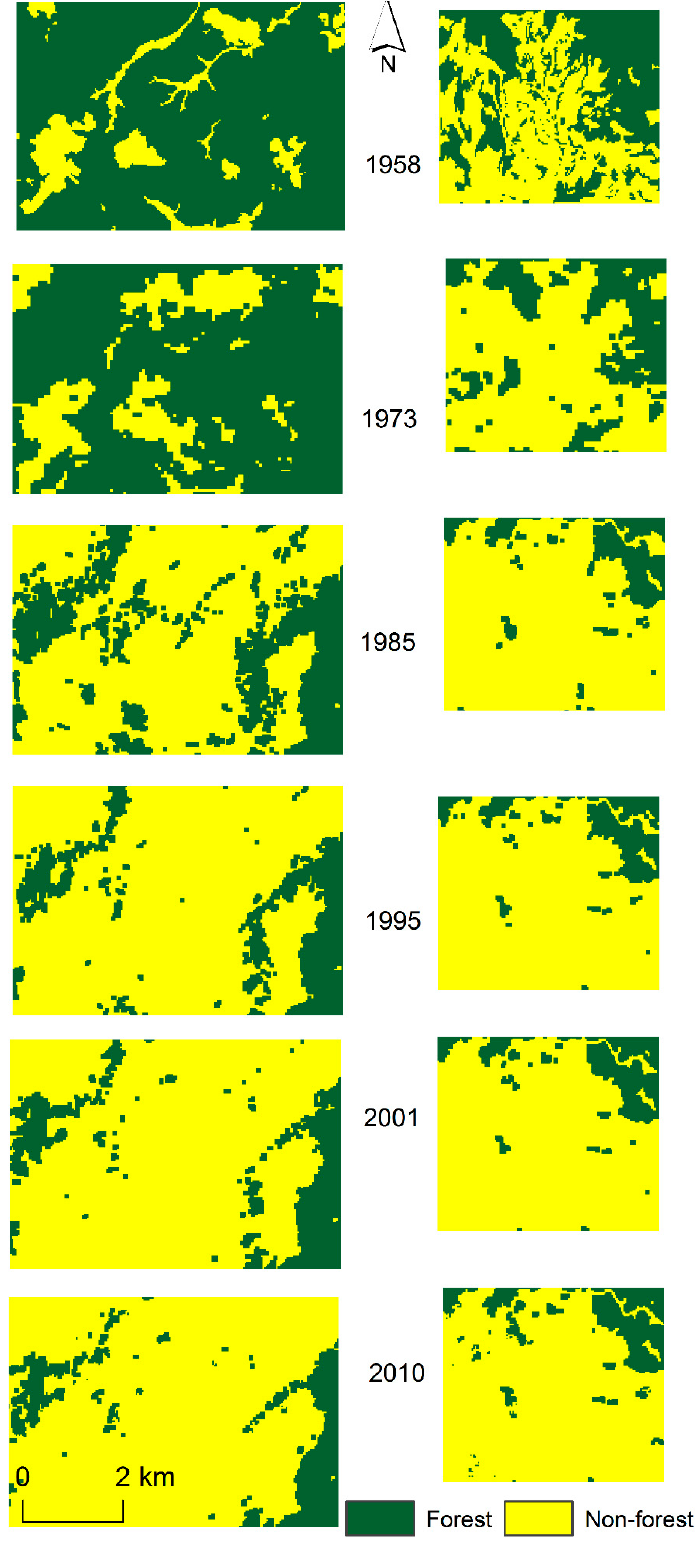
Figure A1. Forest and non-forest land cover in the Muje ( left ) and Sadi-Wanja ( right ) areas of Gera from 1958 to 2010.